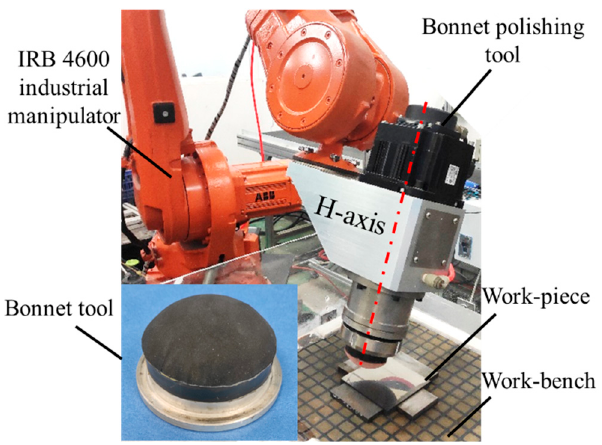
controlled through a PLC electric control cabinet.